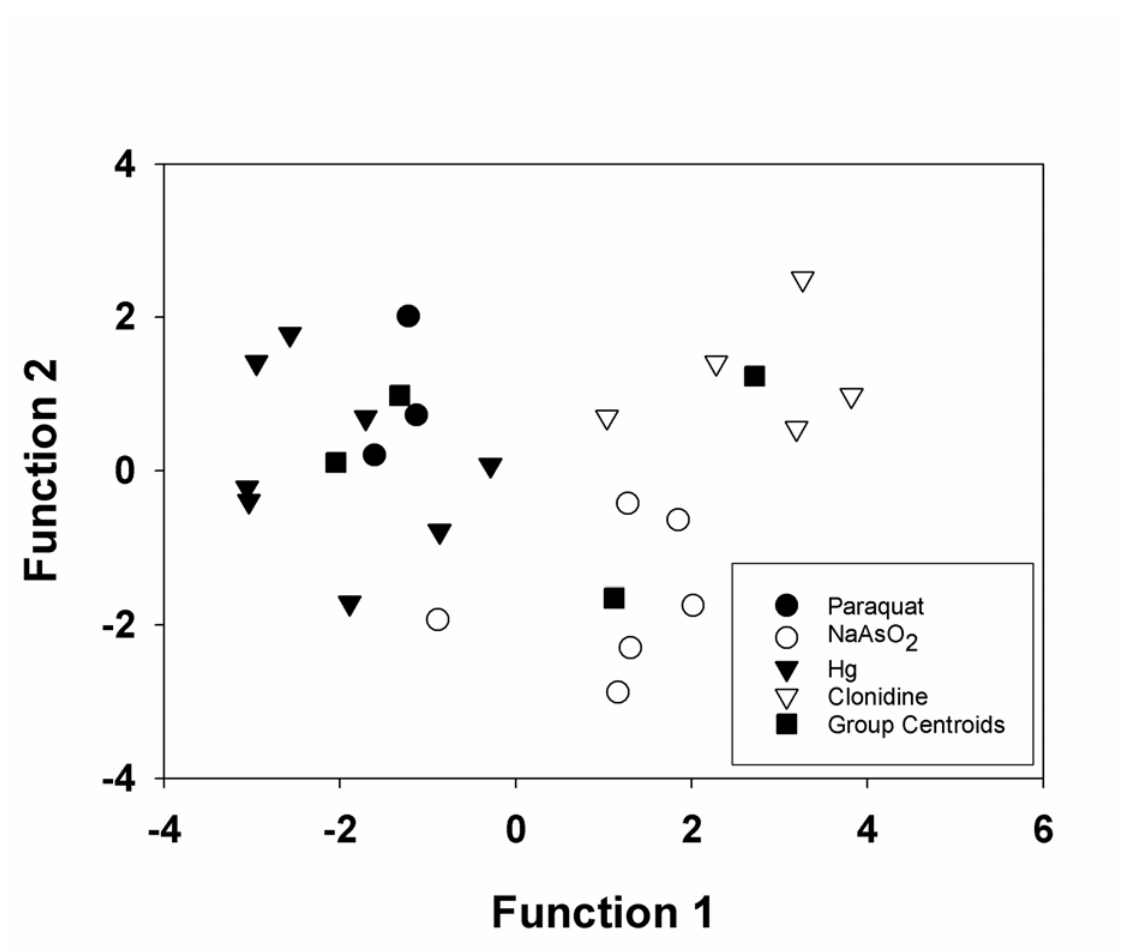
Figure 3. Classification results for combined algal and chromatophore system with concentration as an explanatory variable. Combined analysis consisted of 22 experiments divided into 4 classes mapping to each of the model agents. Function 1 captured 67.98% of the differences with Function 2 capturing 22.02% and Function 3 capturing 10.00%. Wilks-Lambda for all three functions was below 1. The centroids for each class were the average of the discriminant score for each class. The effect of Function 3 on the classification results is not shown